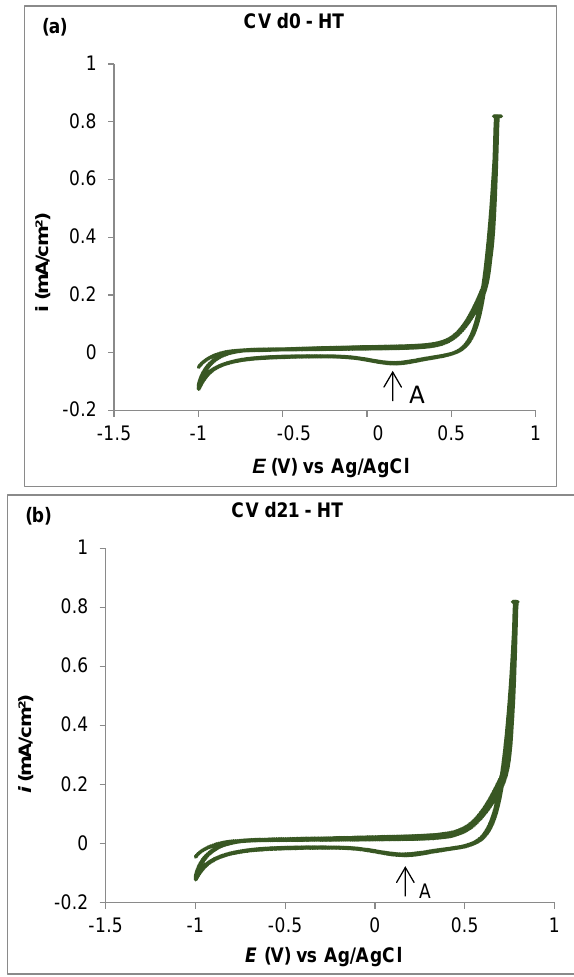
Figure 10. Voltammetrogram for the heat-treated alloy with 0.06% boron at Days ( a ) 0 and ( b ) 21 of immersion.